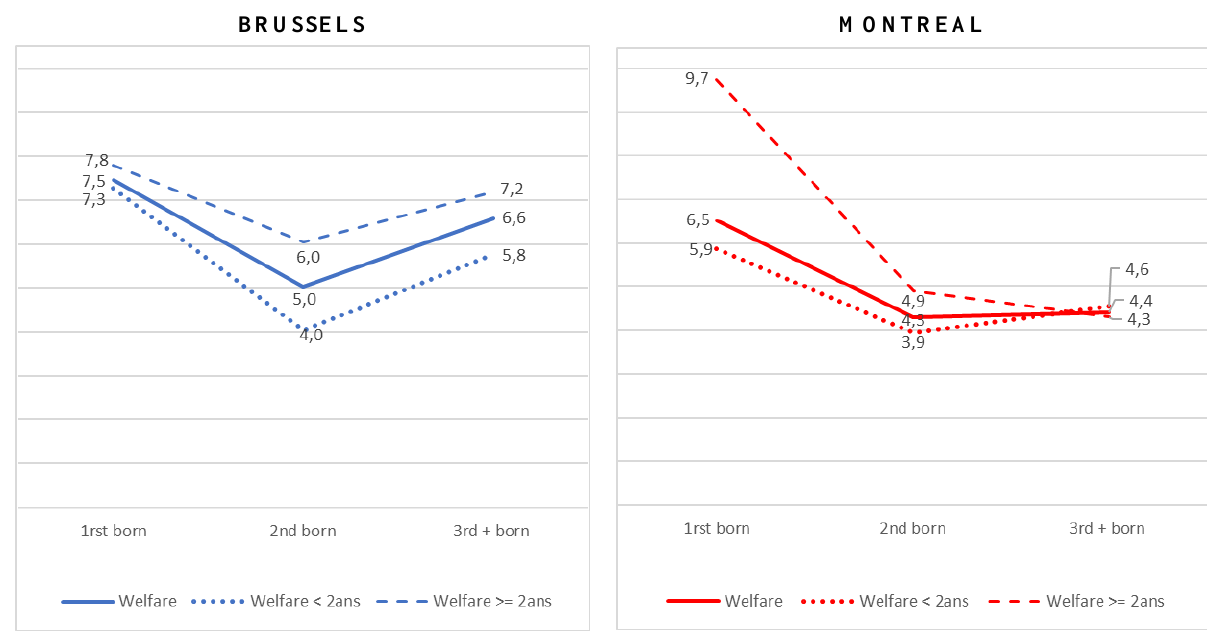
Figure 1. Prevalence of LBW according to birth order in Brussels and Montreal.